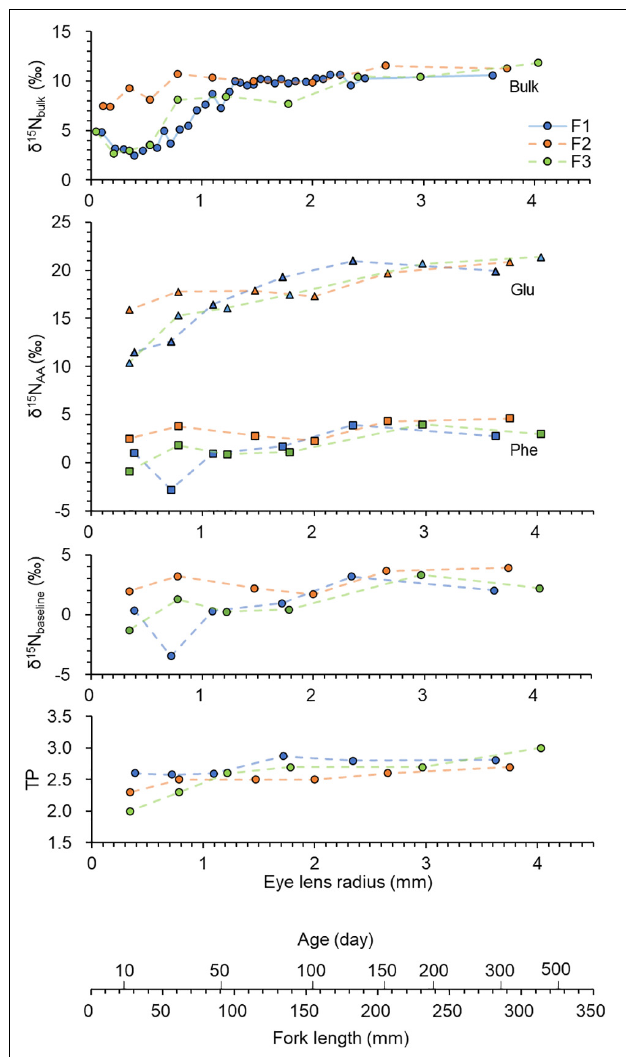
FIGURE 4 | Chronologies of δ 15 N values measured in eye lenses of Chub mackerel ( n = 3), including bulk values and those of individual amino acids (Glu — triangle and Phe — square). The baseline and TP values were calculated using an equation from Chikaraishi et al. (2009) and Xing et al. (2020). Data are plotted against fork length which was estimated using linear regression of fork length and lens radius ( Figure 3 ), and age which was estimated using an equation from Hwang et al. (2008). 34, 33, and 33 laminae were obtained for F1, F2, and F3, respectively. However, only selected laminae were analysed. The solid line indicates continuously analysed laminae, and dotted lines indicate discontinuously analysed laminae.